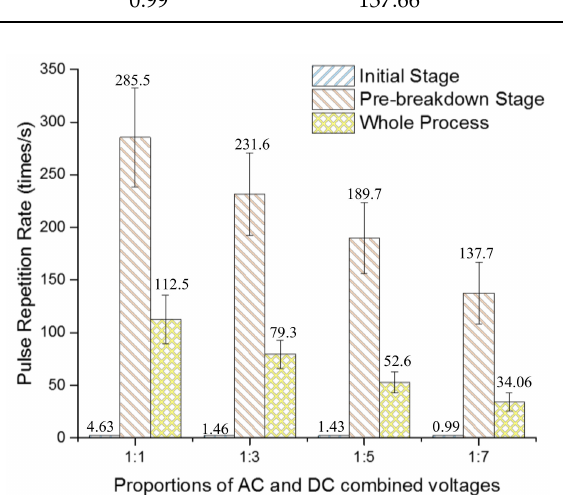
Figure 14. Relationship between pulse repetition rate and AC/DC proportions.